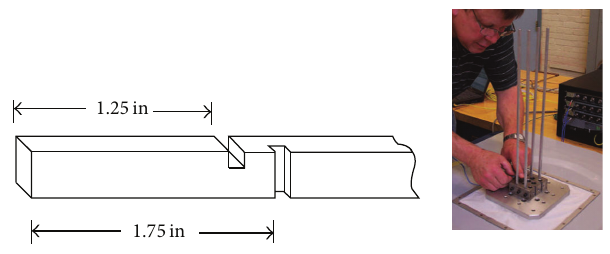
Figure 7: Dimensions of samples tested by French et al. and test setup [12].